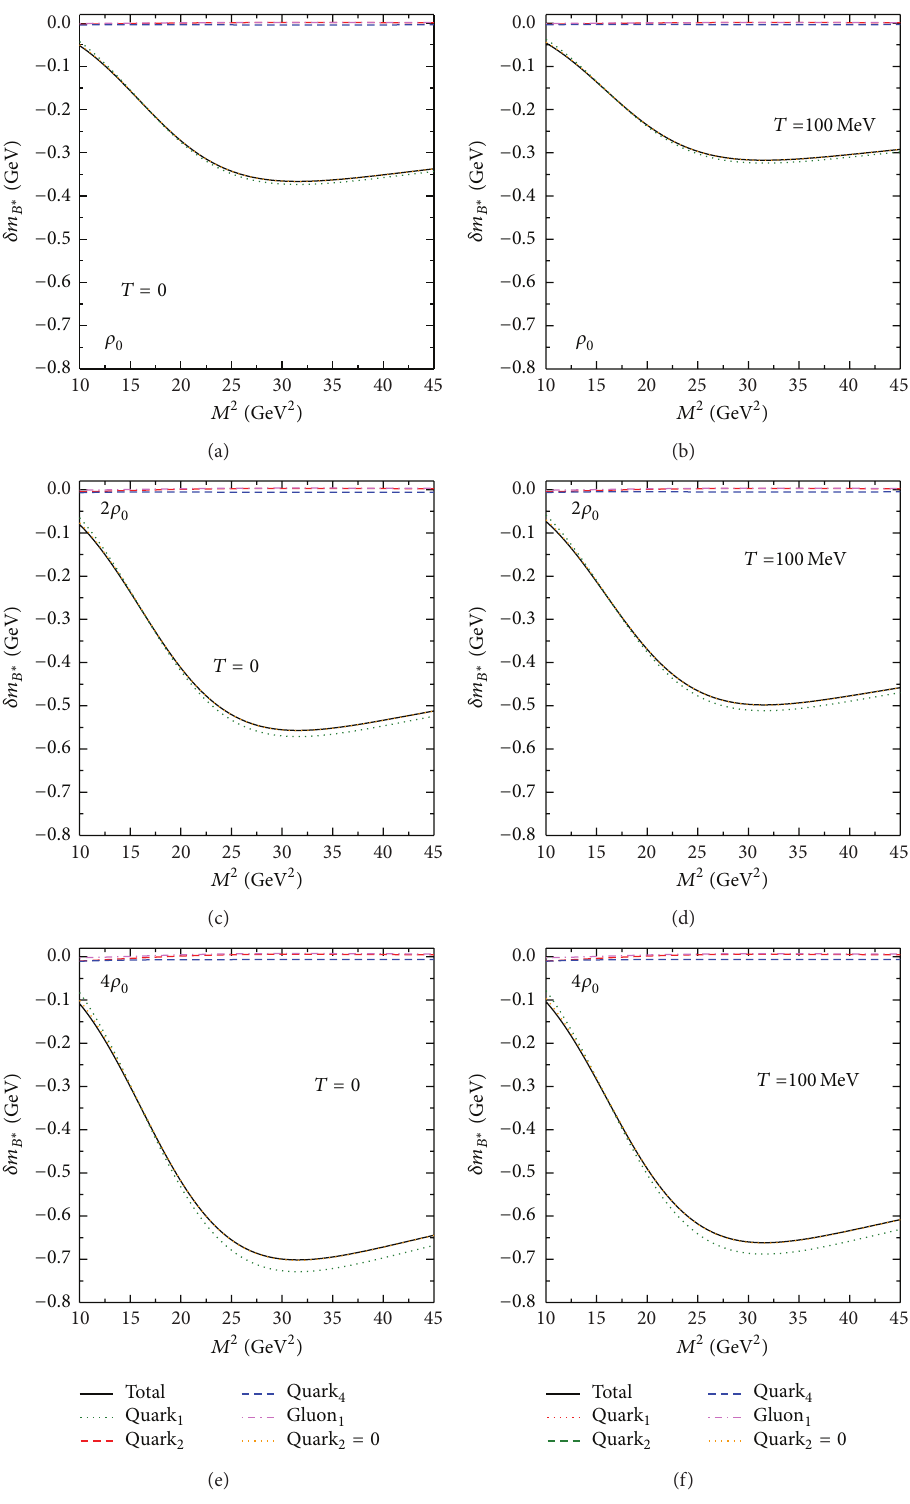
Figure 10: Figure shows the contribution of individual condensates to the mass shift of vector mesons 𝐵 ∗ as a function of the squared Borel mass parameter, 𝑀 2 . The subplots (a), (c), and (e) show the results at temperature 𝑇 = 0, whereas the subplots (b), (d), and (f) are plotted for temperature 𝑇 = 100MeV. We have shown the results at baryon densities 𝜌 0 , 2𝜌 0 , and 4𝜌 0